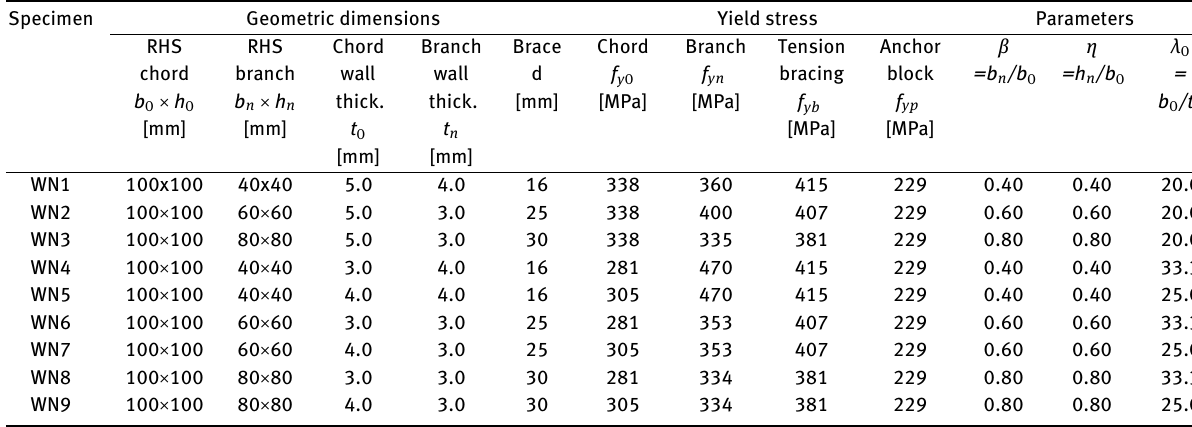
Figure 7: Static scheme of the RHS steel truss Table 1: Specimen geometric dimensions and mechanical properties